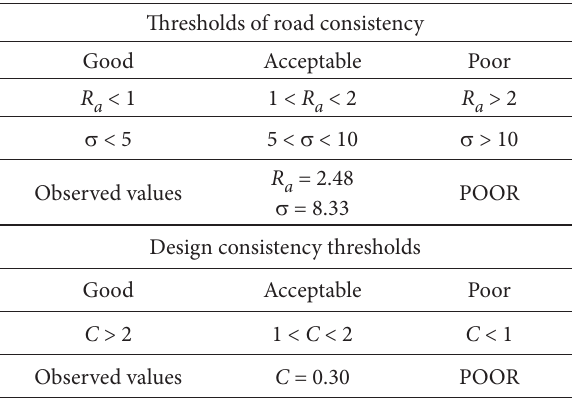
Fig. 4. Example of operating speed profile type and assessing a measure of the consistency Table 3. Geometric consistency